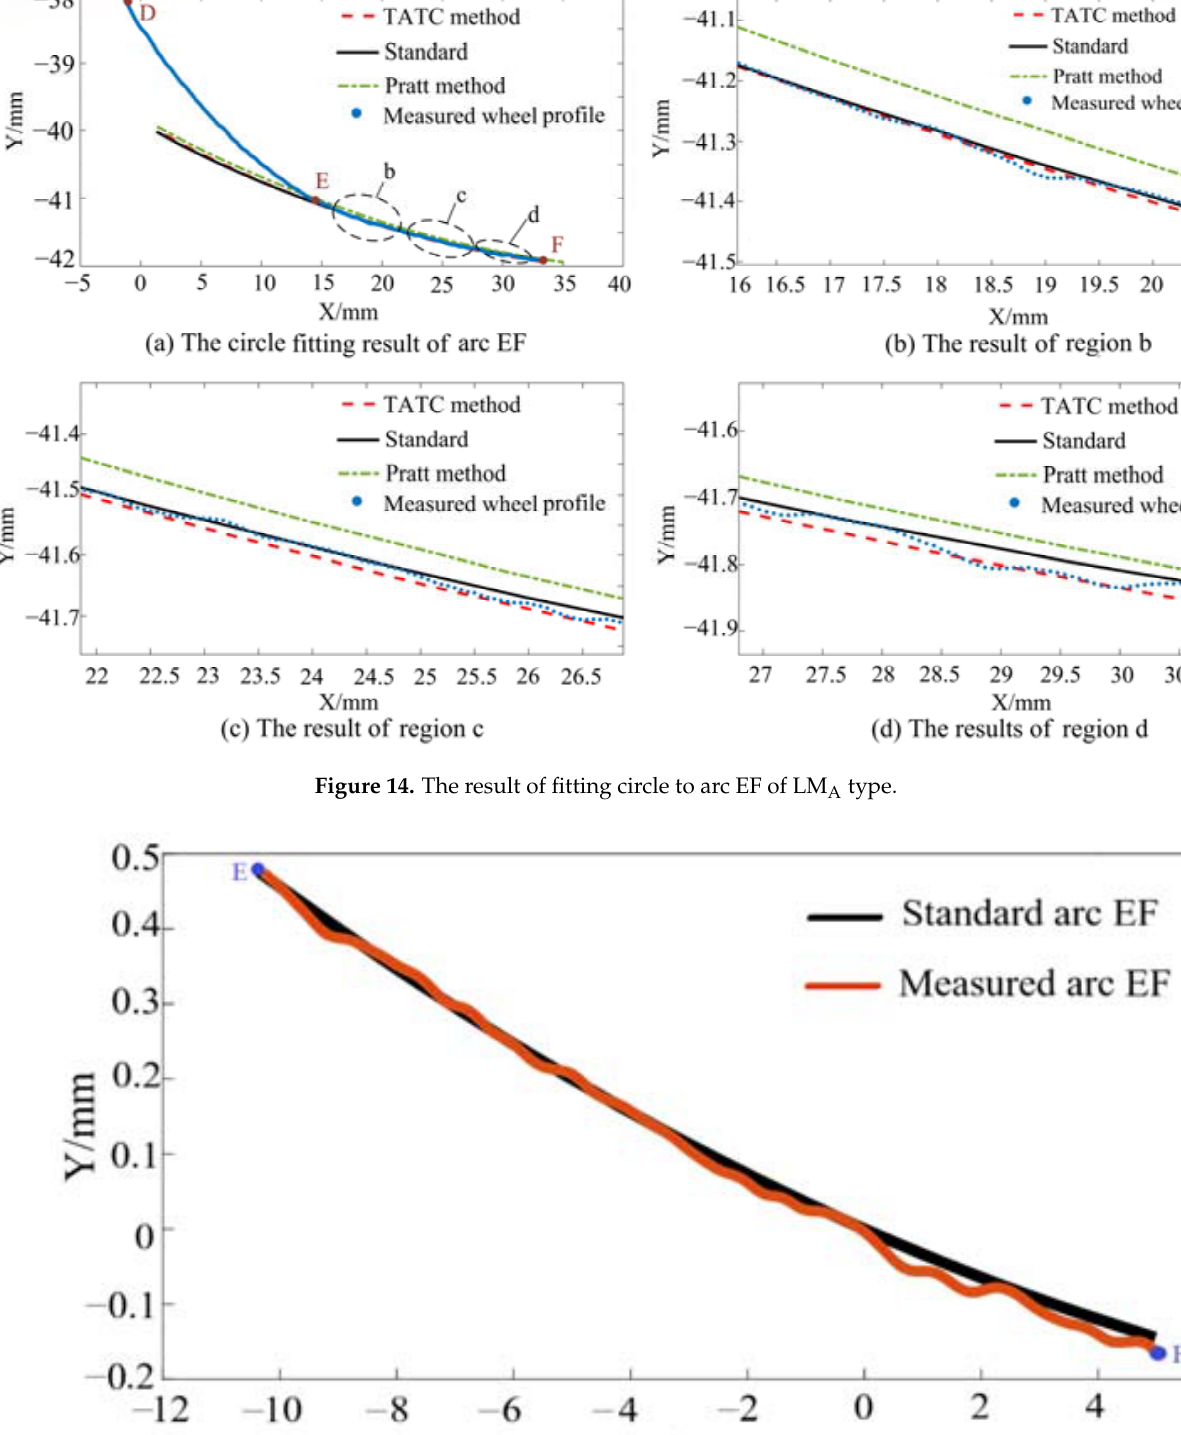
Figure 15. The contrast between measured and standard arc EF.